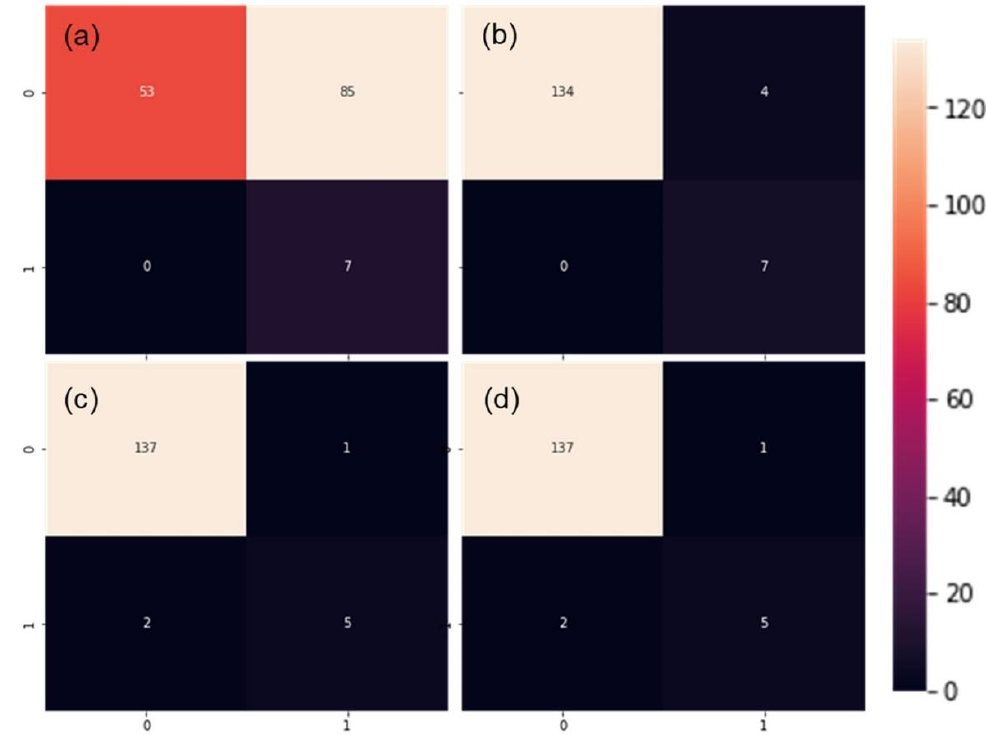
Figure 5. Performance of single and multilayer perceptron ( a , b ), convolutional neural network ( c ) and support vector machine ( d ) calibrated models with external dataset. Quadrants from left to right, top to bottom represent true negatives, false positives, false negatives and true positives.